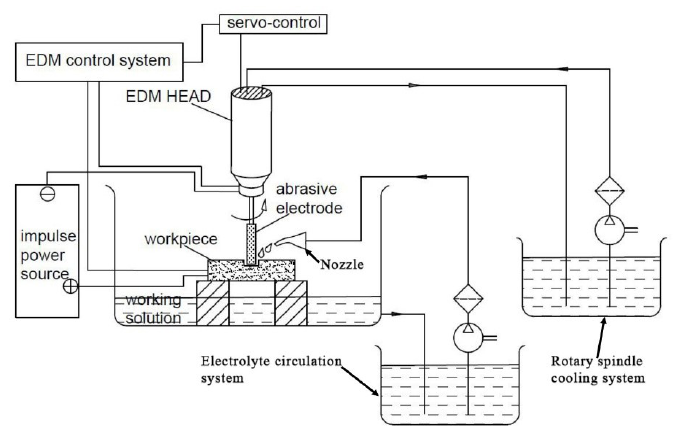
Figure 2: The principle of synchronous hybrid ECDGM with shaped abrasive electrode.